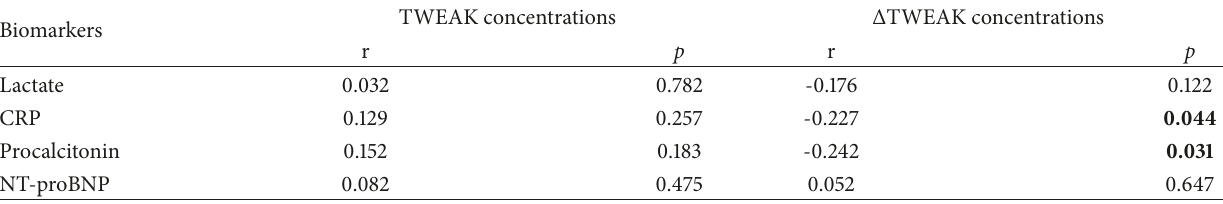
Table 3: Correlation of TWEAK concentrations and other biomarkers.